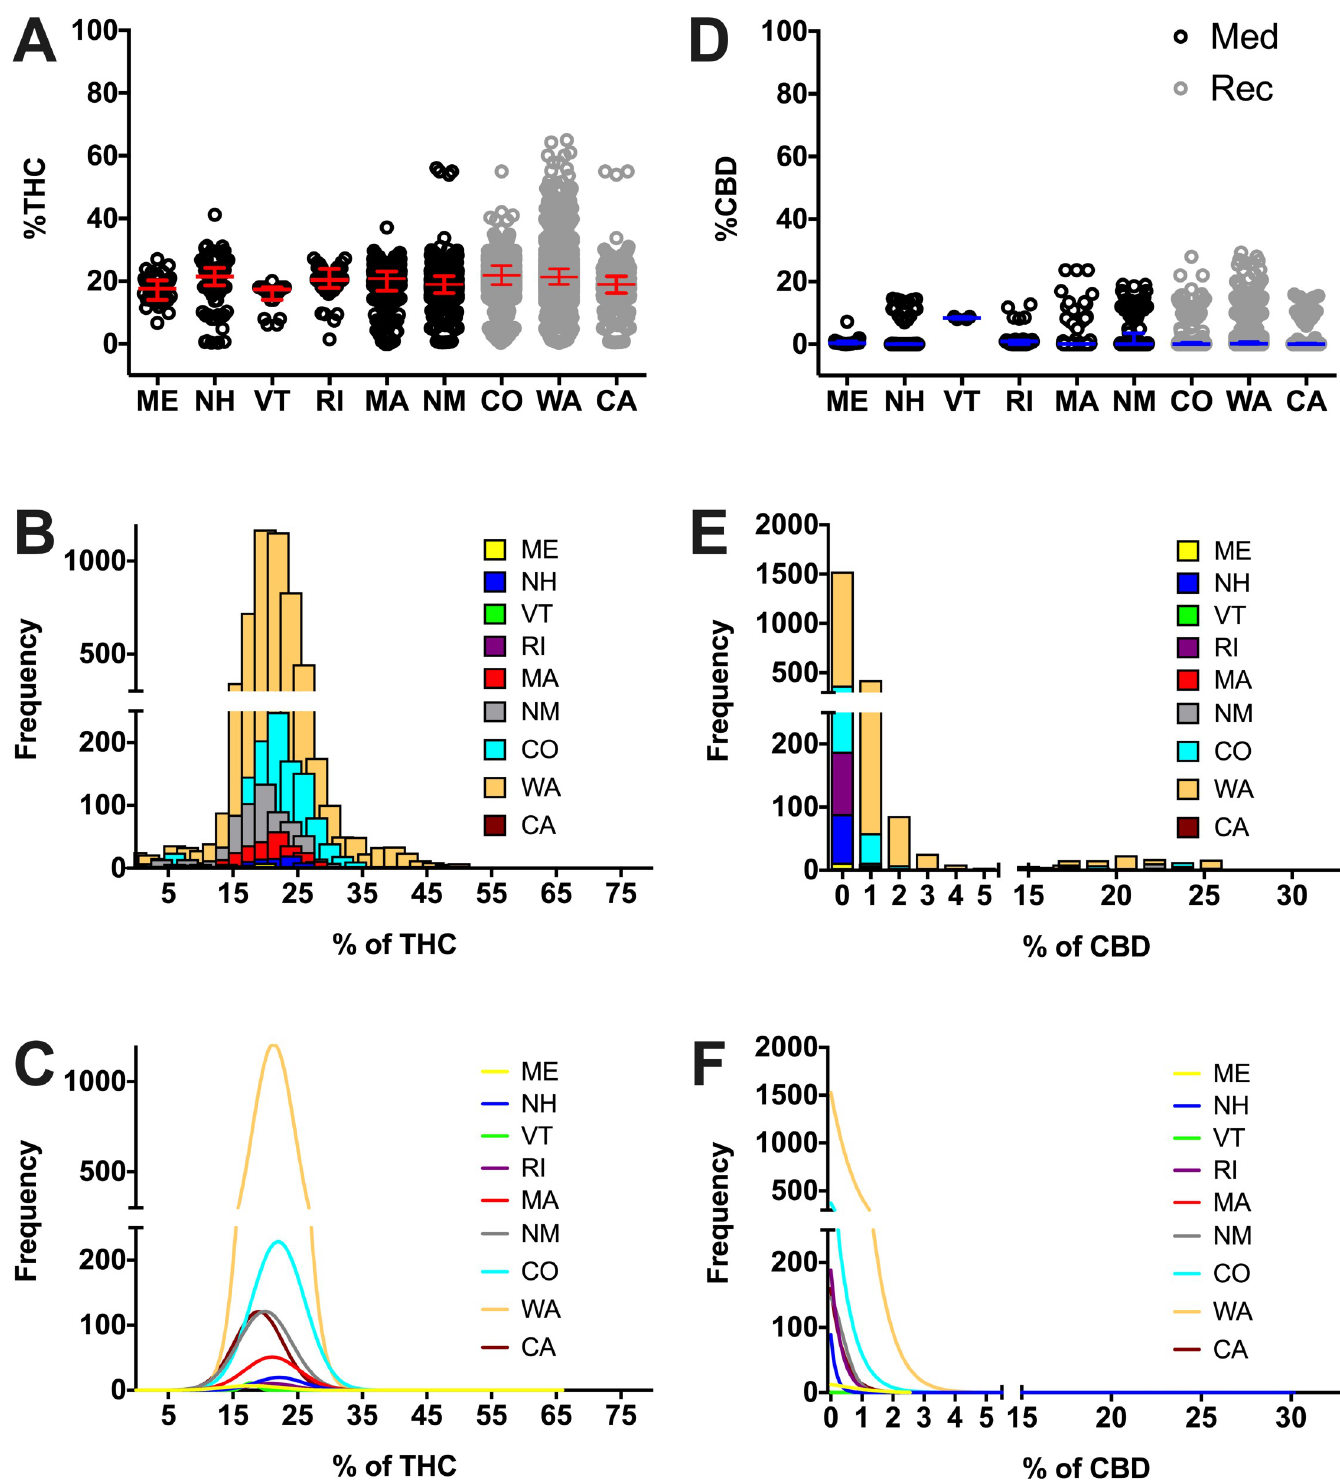
Fig 2. Percent THC (A) and percent CBD (D) per state. Percent THC and CBD was obtained from dispensary websites for herb cannabis products in the surveyed states and plotted as circles. States with medicinal only (Med; black circles) and recreational and medicinal (Rec; grey circles) programs were compared. Data are presented as median with interquartile range. For clarity we do not show the statistic differences among states, statistical analysis results and descriptive statistics could be found in S4 and S5 Tables. Frequency histograms of products in relation to THC (B) or CBD (E) and their respective Gaussian fit curves (C and F) show